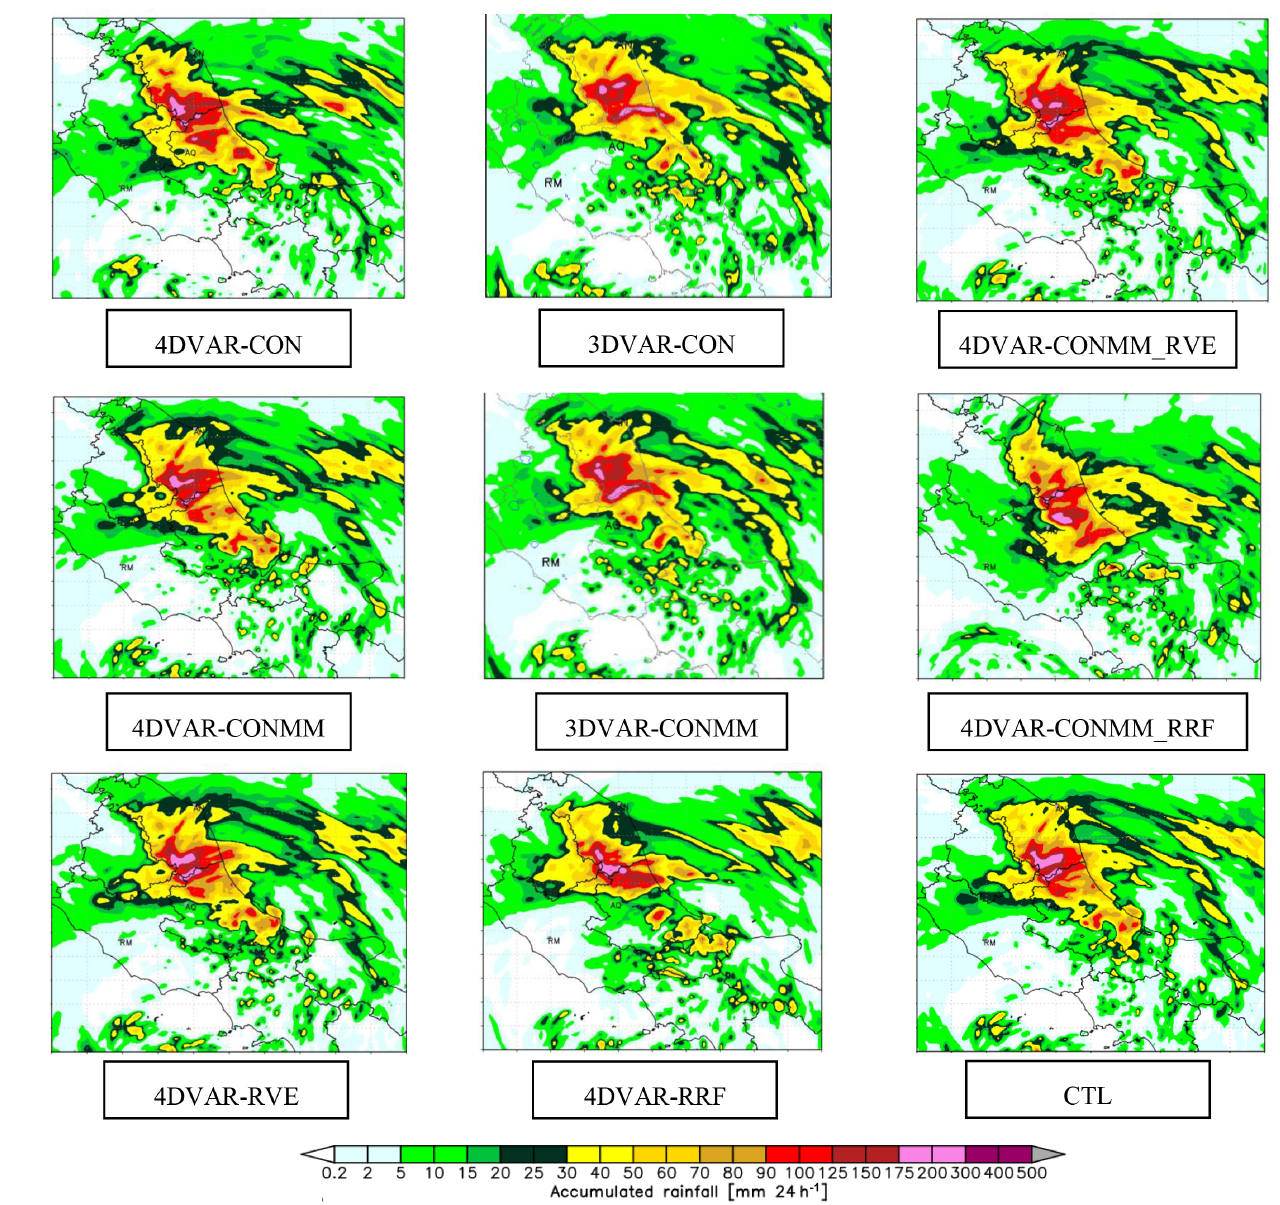
Figure 4. 24h forecast precipitation at 00:00UTC, 15 September 2012 estimated by WRF experiments. The latter acronyms are indicated in the black border